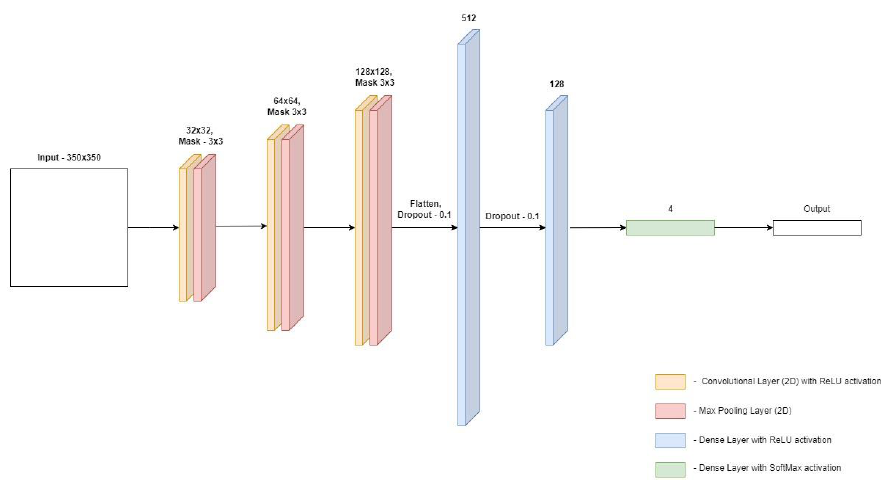
Figure 8. Architecture of the first convolutional neural network model.